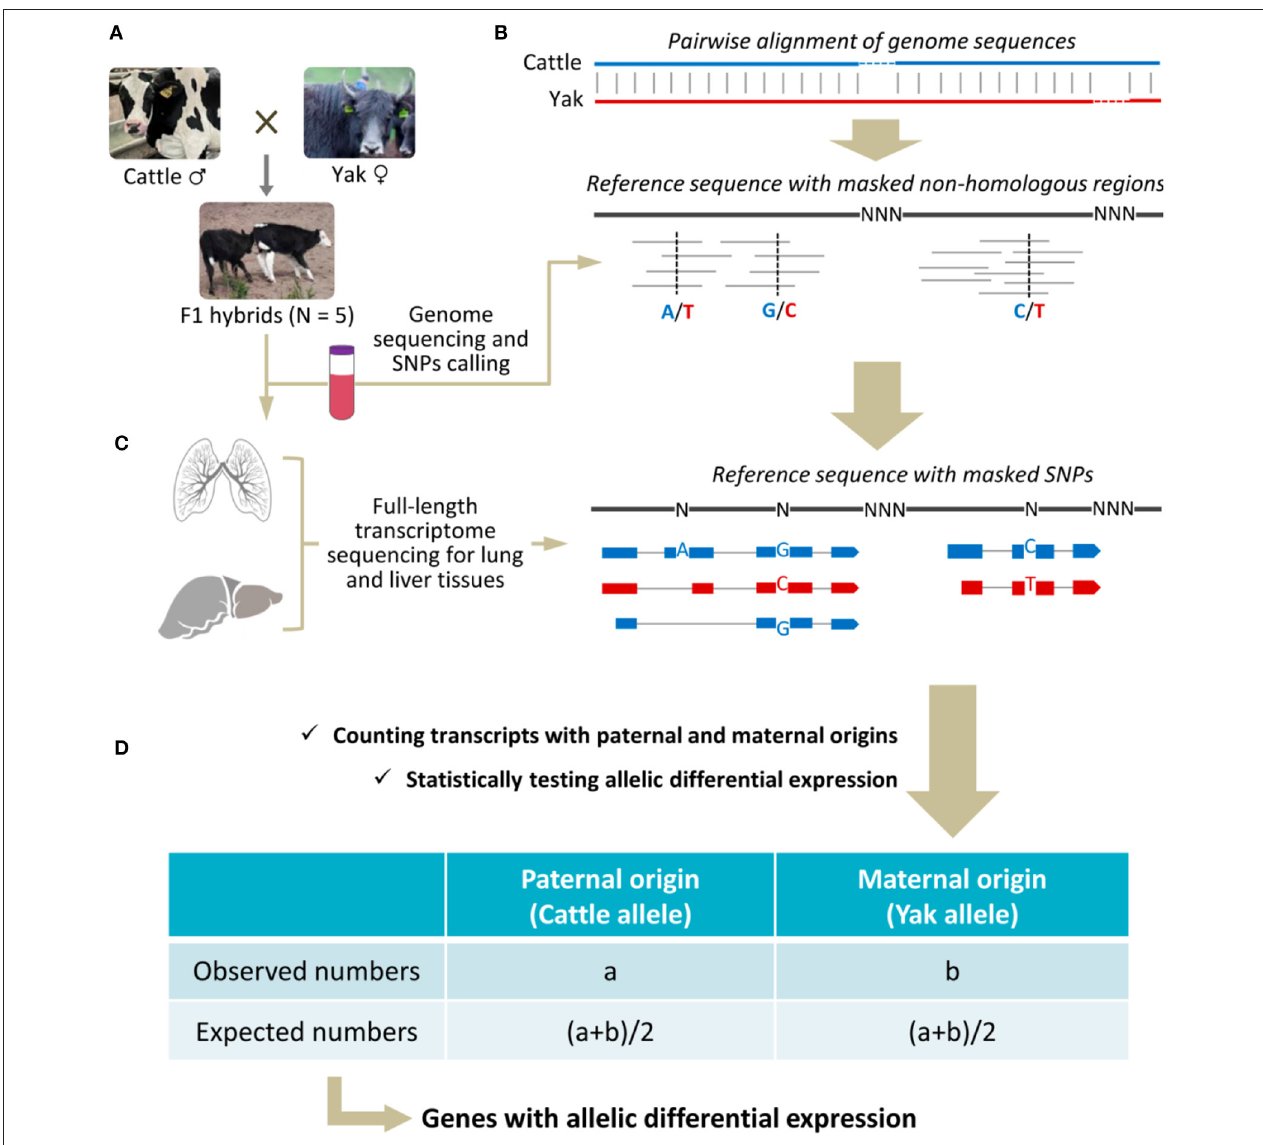
FIGURE 1 | Schematic illustration of sample collection (A) , preparation of reference genome sequences (B) , sequencing and mapping of the long reads (C) , and quantification and statistical testing of parental allelic expression (D) .